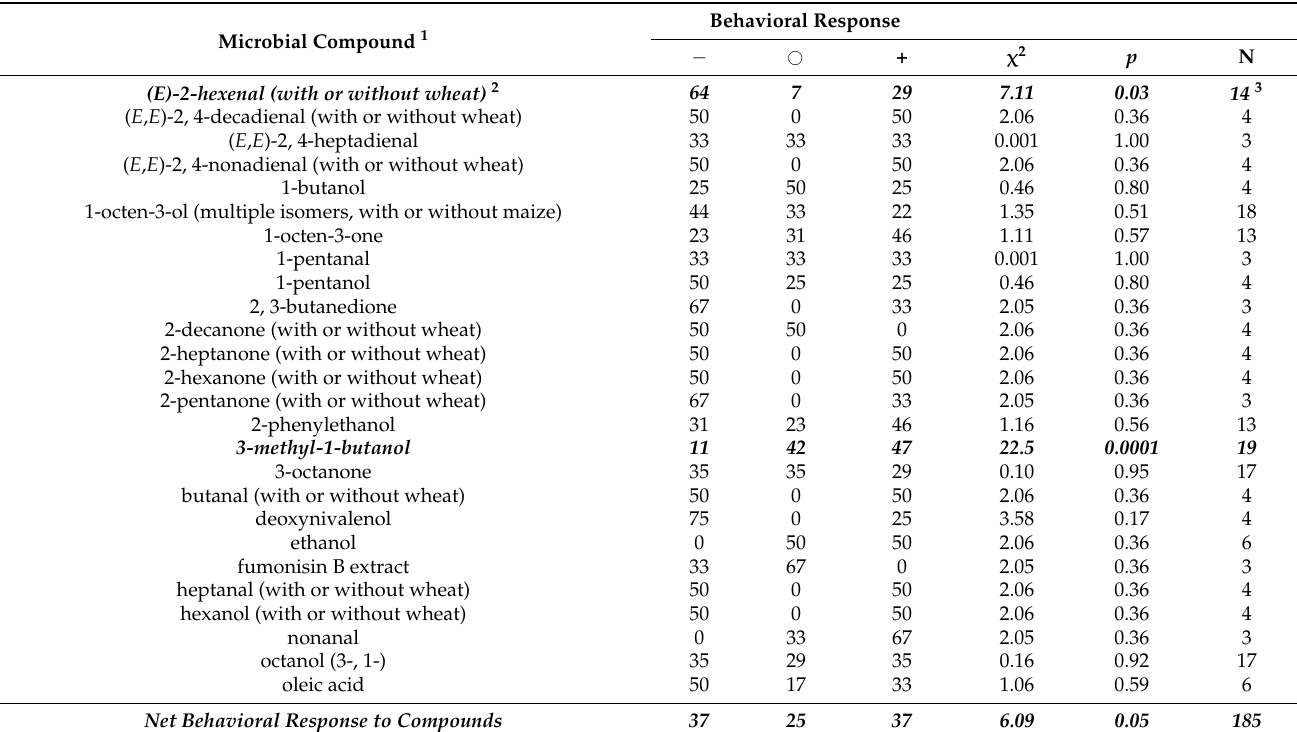
Table 4. The behavioral response among 19 stored-product arthropod species from the primary literature to the following specific microbially produced organic compounds, including documented attraction (+), repellency ( − ), or no statistical difference from included controls ( ). (cid:35) Microbial Compound